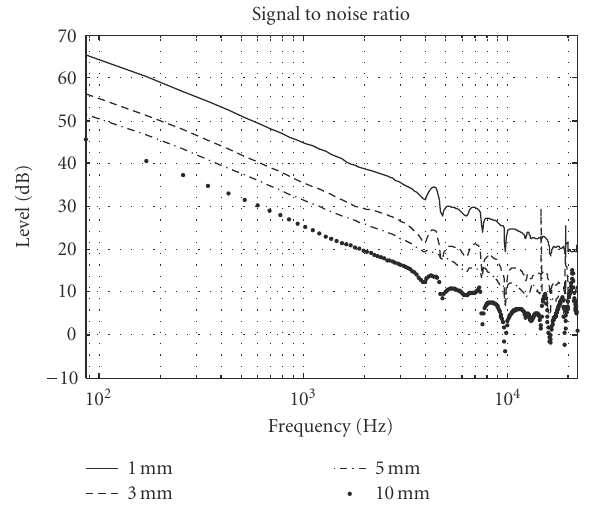
Figure 7: Signal-to-noise ratio versus frequency due to position er- rors.